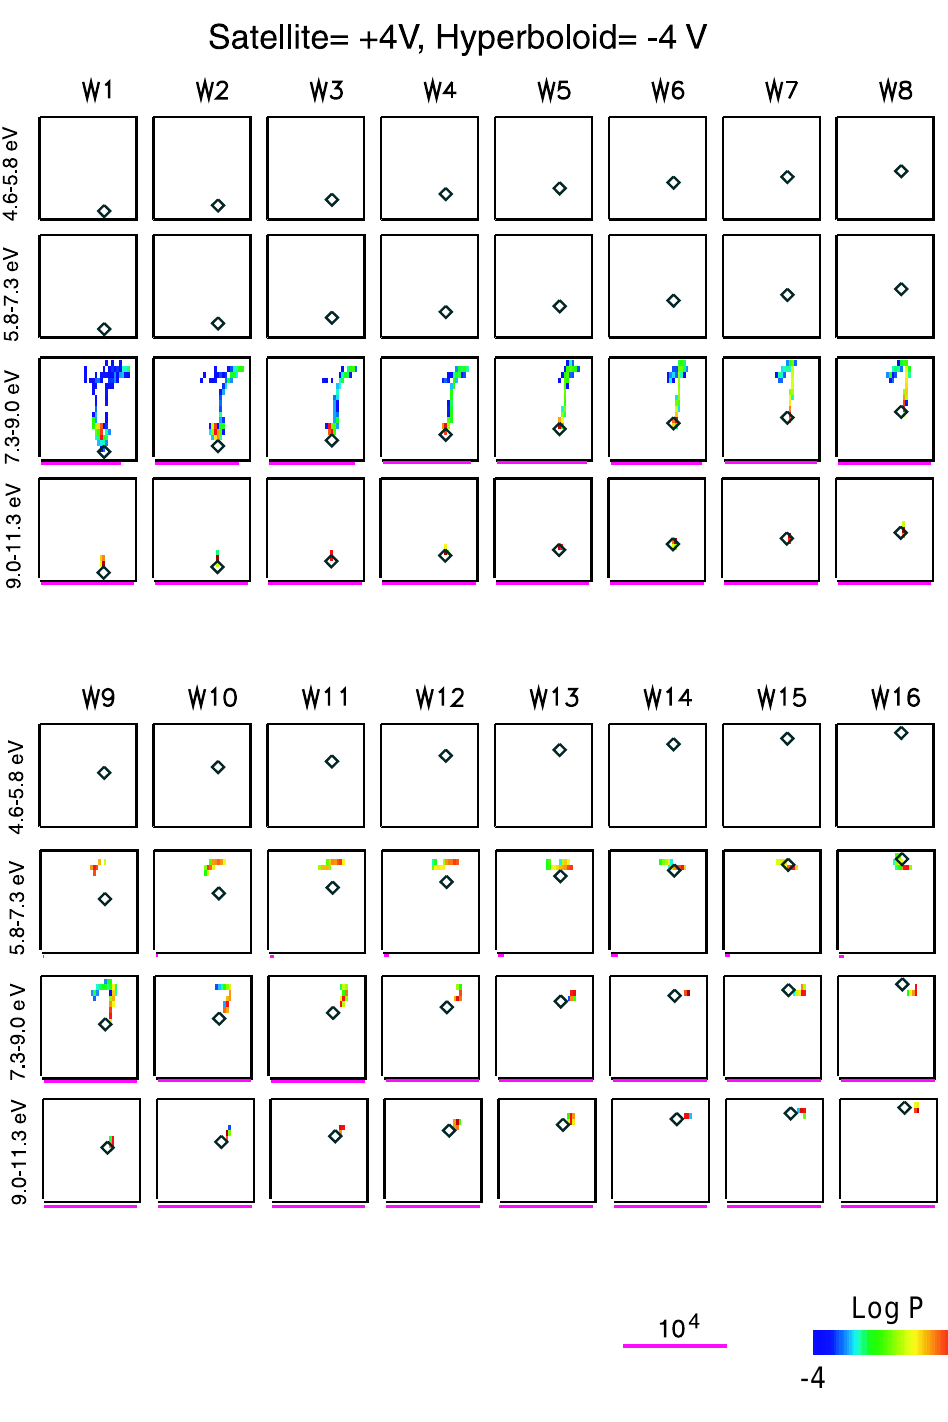
Fig. 5. Probabilities of incoming direction for a particle detected by a window and within an energy channel. The horizontal and vertical axes display the polar angle (top: 0 ◦ to bottom 180 ◦ ) and the azimuthal angle (left: 90 ◦ to right: 360 ◦ ), respectively, with an angular resolution of 10 ◦ . Diamonds indicate the viewing direction of each window. The pink bar below each plot represents the number of computer particles reaching the outer boundary of the simulation system normalised to the number of ions launched from each